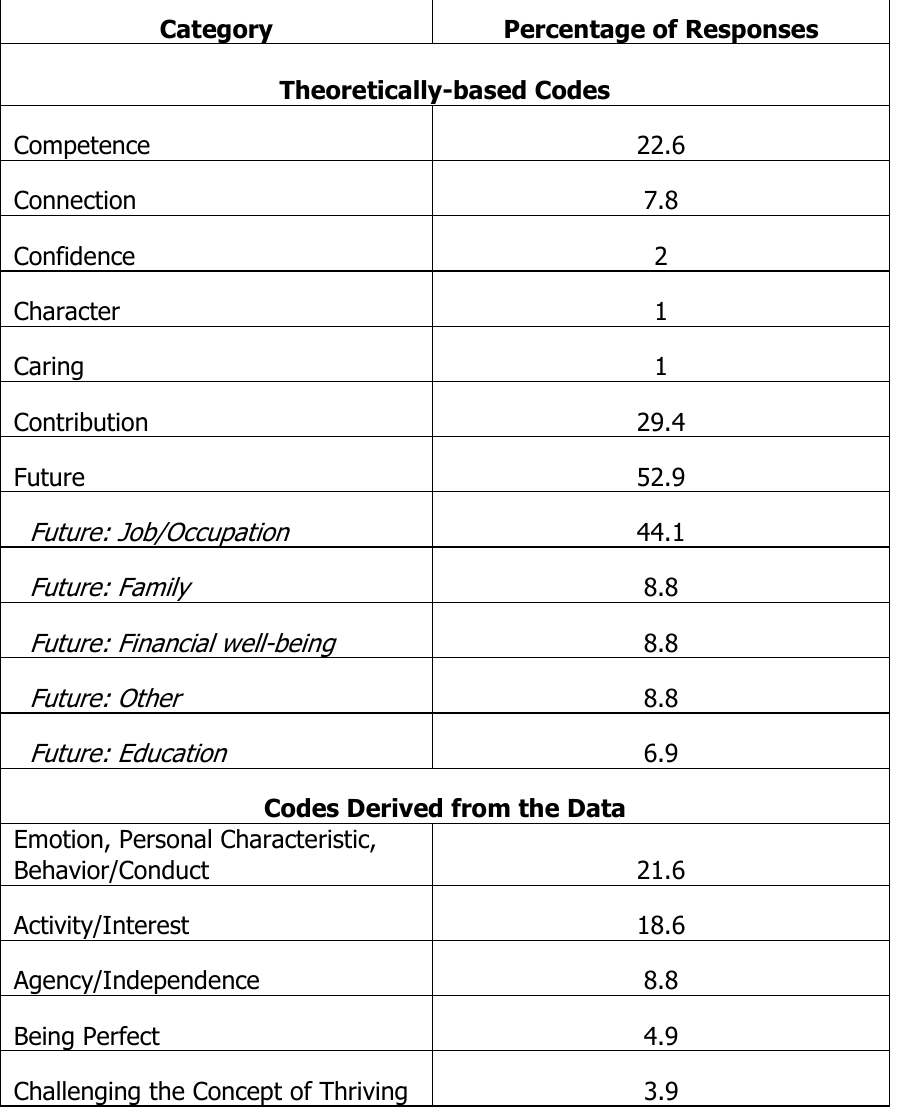
Coding categories and response percentages to questions about the characteristics of a thriving youth among immigrant youth,